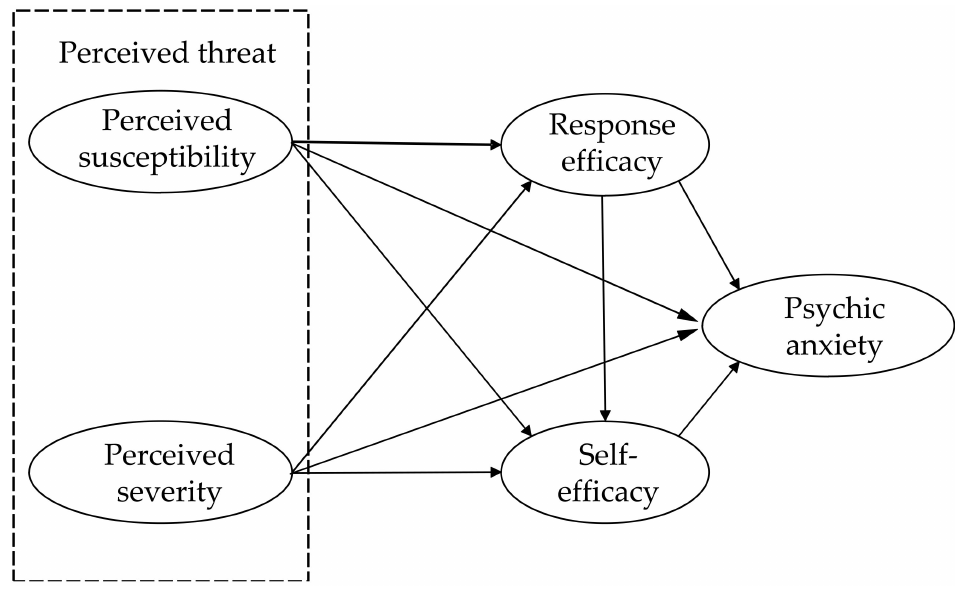
Figure 1. Research